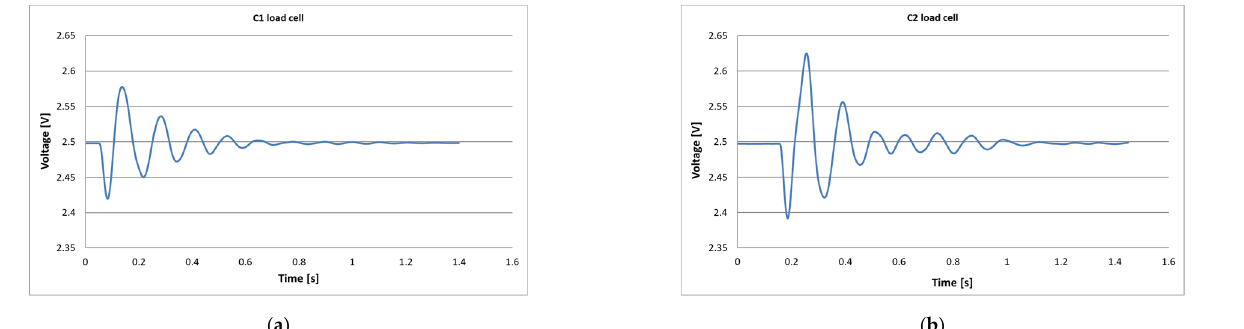
Figure 10. Effective silent-block behavior for dynamic tests performed on: ( a ) Load cell (C1); ( b ) Load cell (C2).